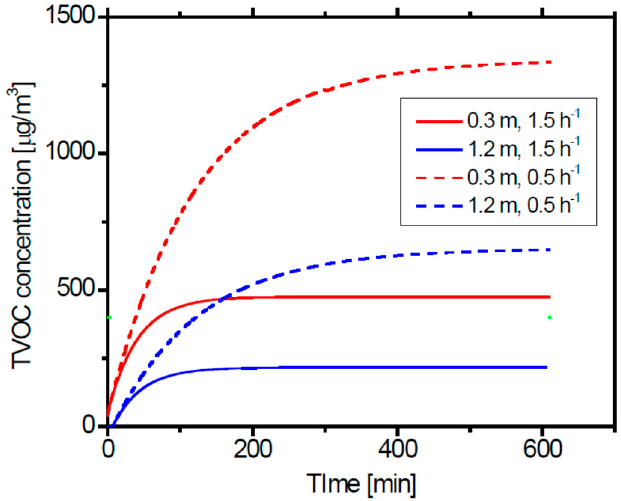
Figure 6. Simulation results of the TVOC concentration change with time for the cases of the air exchange rate was same as the one just after completion, but reduced air exchange rates of N = 1.5 h − 1 and 0.5 h − 1 .